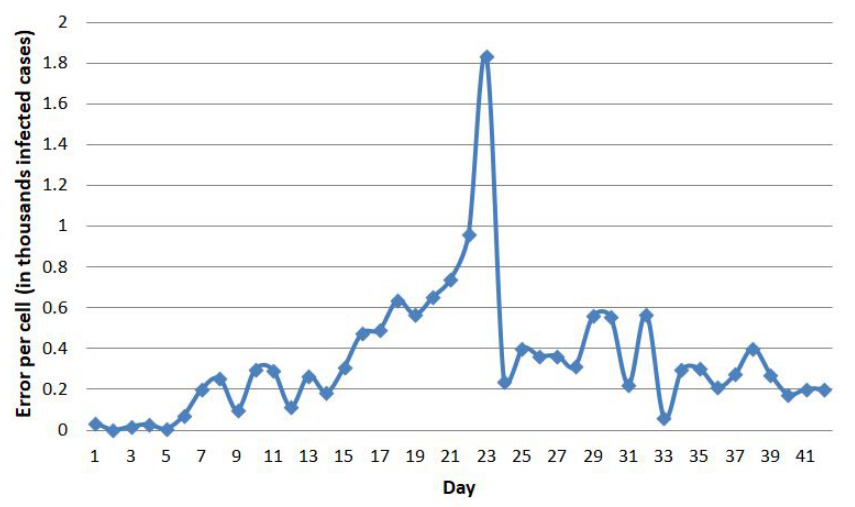
Figure 12. The error of the model fit for